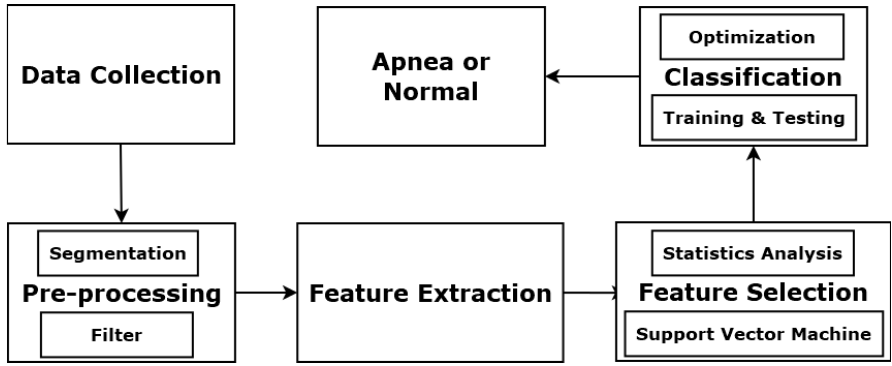
Figure 1. Components of OSA detection system.